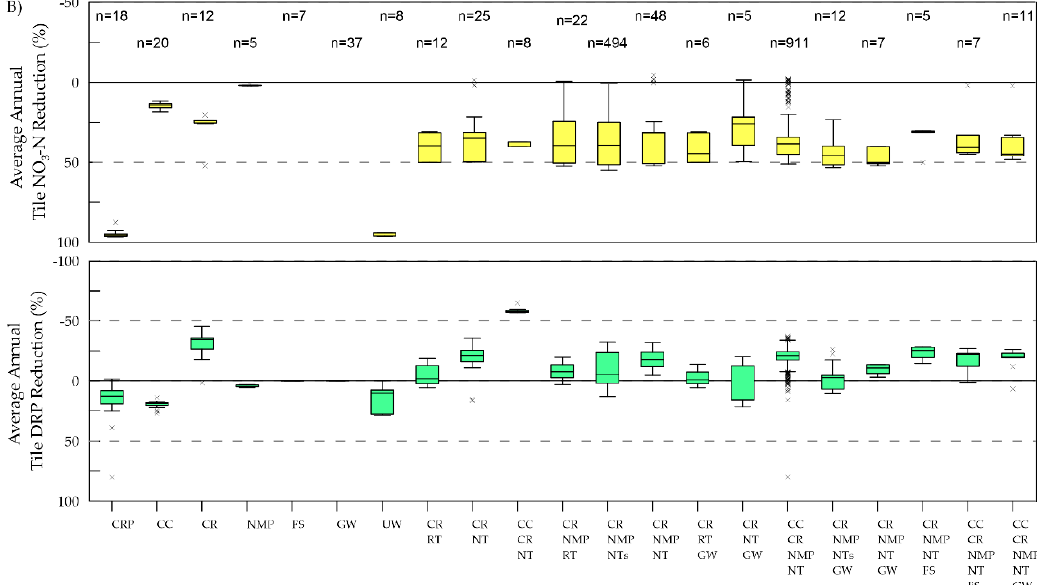
Figure 8. Simulated average annual reductions by selected best management practices (BMPs) and BMPs combinations in ( A ) surface runoff and ( B ) tile drainage in Eagle Creek watershed, Ohio. Negative values indicate an increase in sediment or nutrients. Boxplots: Rectangle represents the interquartile range with median indicated, whiskers extend to the minimum and maximum values after exclusion of any outliers; circles are outliers, defined as values extending beyond the rectangle by more than 1.5 times the interquartile range. (CC = cover crops; CRP = conservation cover; CR = crop rotation; DRP = dissolved reactive phosphorus; FS= filter strip; GW = grassed waterway; n = number of HRUs with BMP or BMP combination implemented; NMP = nutrient management plan; NO 3 -N = nitrate-nitrogen; NT = no-tillage; NTs = no-tillage following the corn harvest prior to soybean planting; PG = prescribed grazing; RT = reduced tillage; TP = total phosphorus; UW = Upland Wildlife Management.) Note: The number of practices and HRUs may differ between parts A and B because not all fields were simulated with tile drainage.